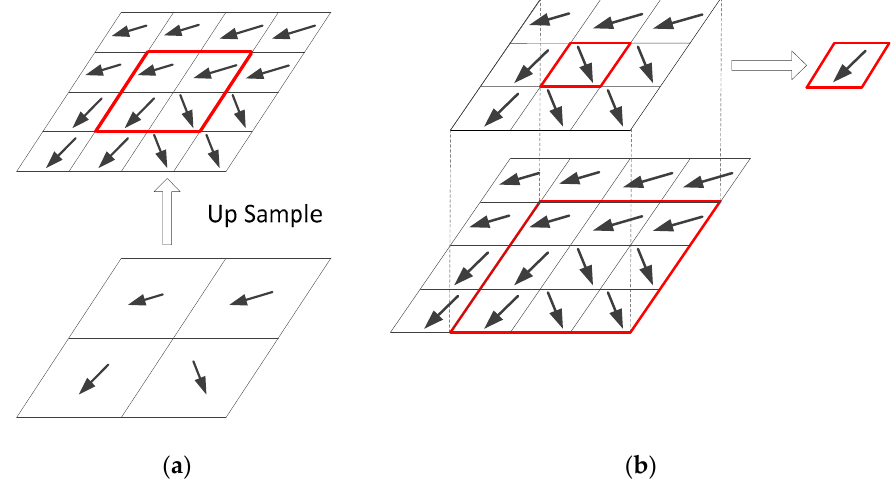
Figure 4. Hierarchical ME: ( a ) Upsample MVF; ( b ) MV selection .